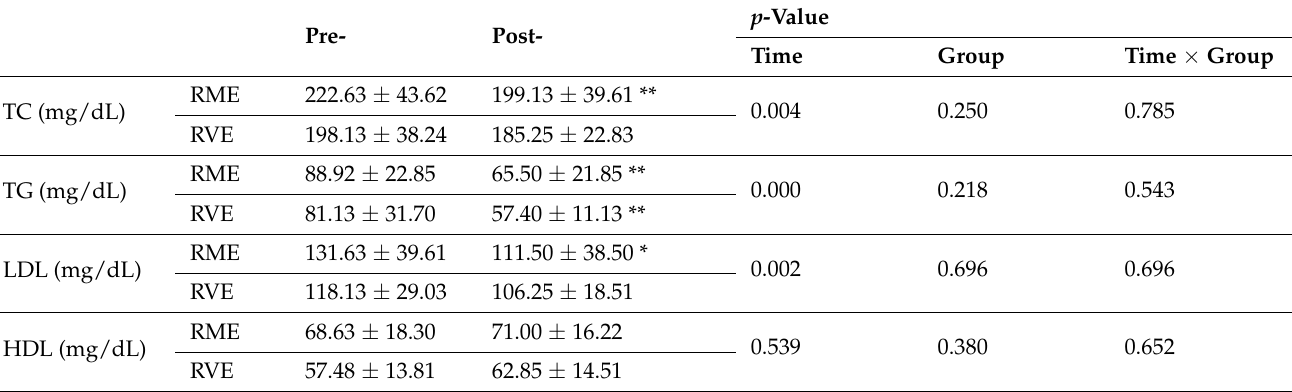
Figure 2. Body fat (%). Significantly different pre-vs. post-intervention at ** p < 0.01.